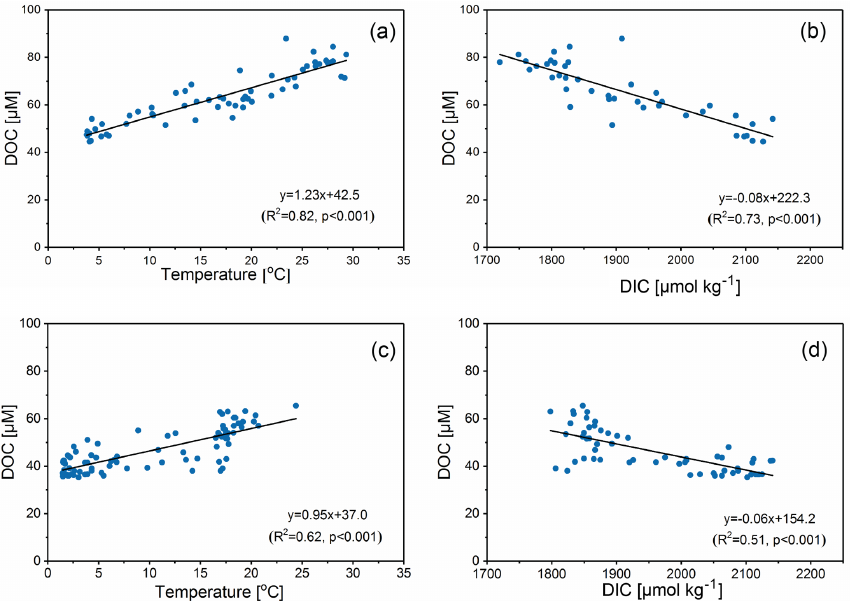
Figure 6. Correlation of DOC concentrations with water temperature and DIC concentrations for stations sampled in the (a, b) ECS and (c, d) KE. The solid lines denote linear regressions fit to the